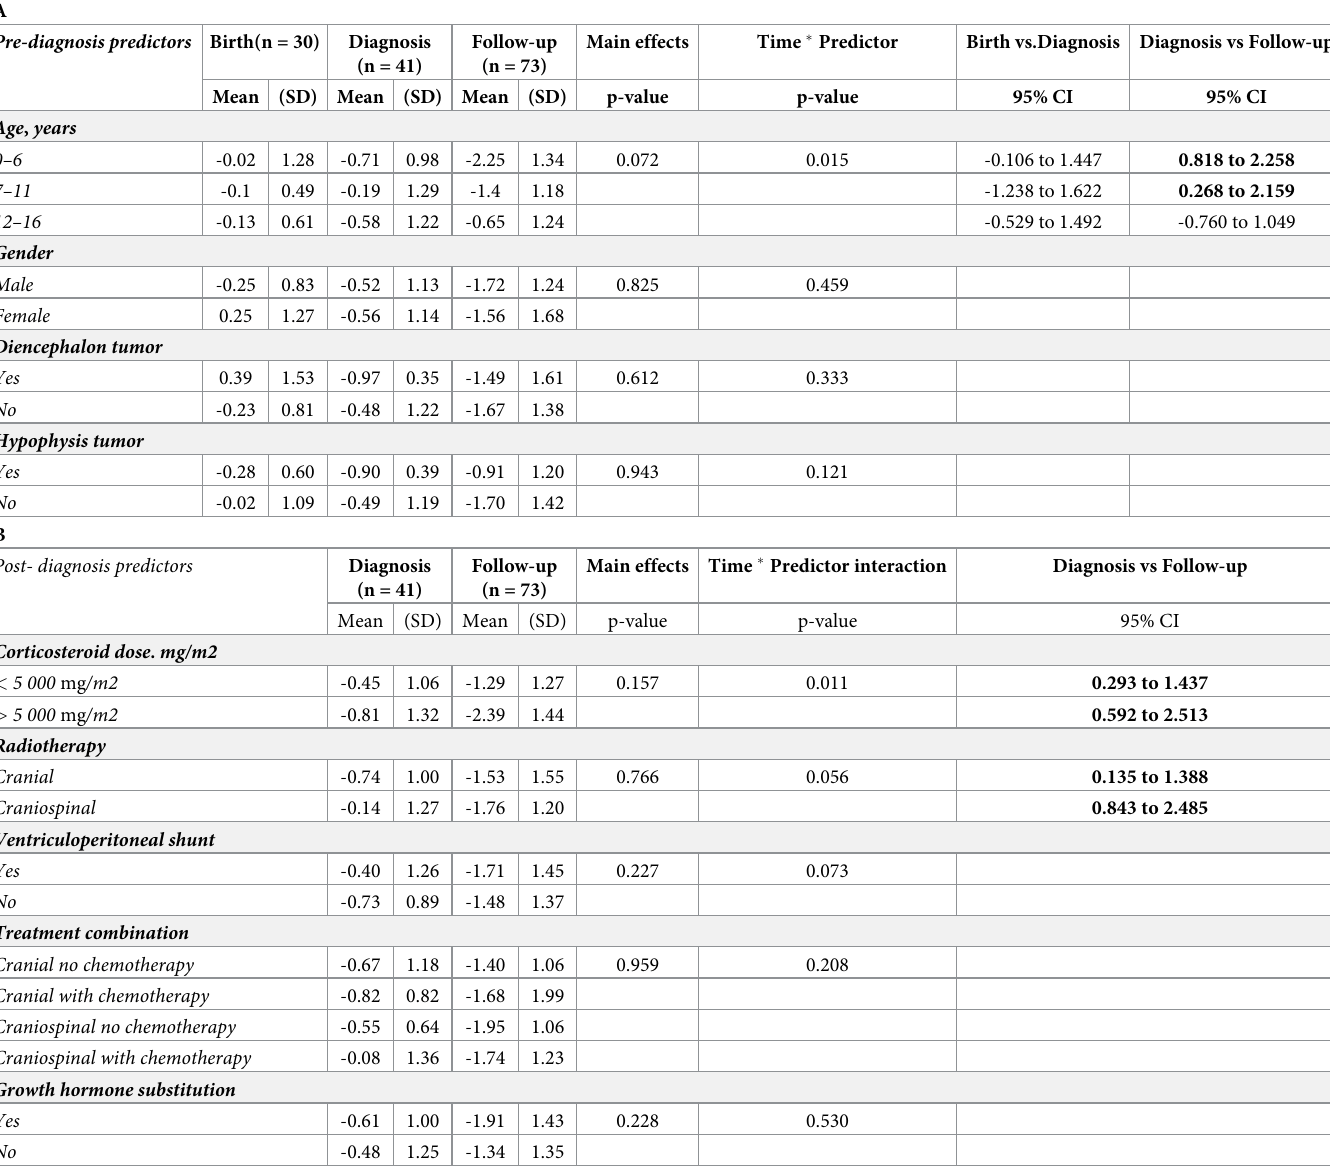
Table 2. Linear mixed model analysis with pre- (A) and post-diagnosis (B) growth